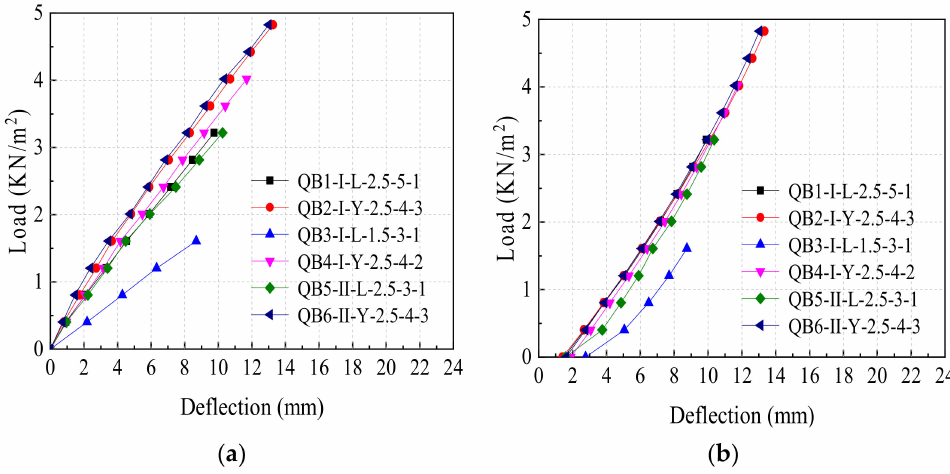
Figure 13. The overall mid-span deflection curve of specimens. ( a ) Loading; ( b )